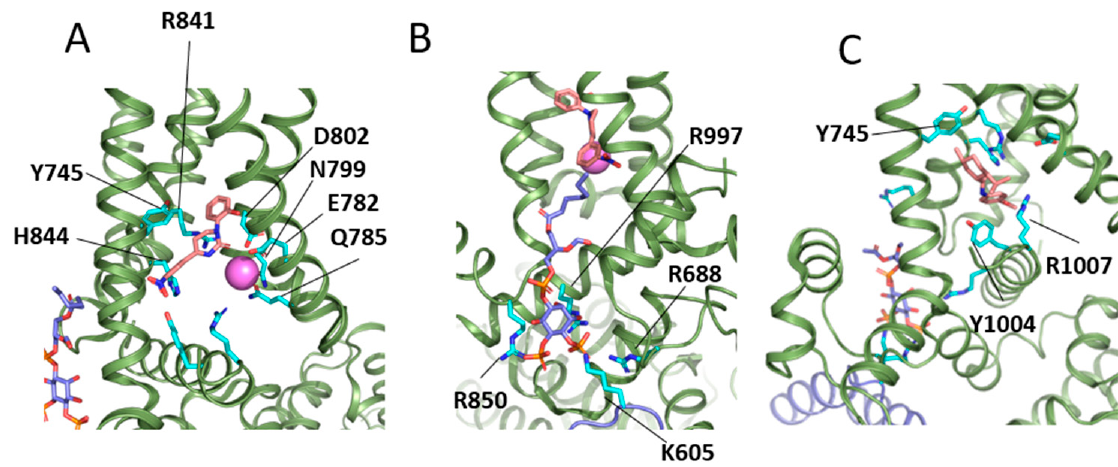
Figure 7. Representation of TRPM8 effectors at their binding sites. Panel ( A ) shows a detail of the icilin agonist bound to the menthol binding site in the presence of calcium (PDB code: 6NR3 [106]), together with the main residues involved in binding: Y745, Y1004, R841, E782, H844, R1007 for icilin, and N799, D802, E782, and Q785 for calcium. Residues are colored cyan, and calcium is violet. The molecule colored in blue to the left is PIP 2 . ( B ) PIP 2 (blue) is bound to the interfacial site in TRPM8, distinct from that of vanilloid receptors. Residues interacting with PIP2 binding are K605, R688, R850, and R997. ( C ) TRPM8 agonist WS12 bound in the menthol site. TRPM8 is activated by cooling compounds (menthol, icilin) and is modulated alloster- ically by calcium and PIP 2 . Although the binding site of natural menthol or synthetic icilin partly overlaps, the mechanisms by which these agents activate the channel are rather different. For instance, calcium is only required for icilin activation (Figure 7A) [107] but not for menthol or cold activation [4]. PIP 2 (Figure 7B) is allosterically coupled to